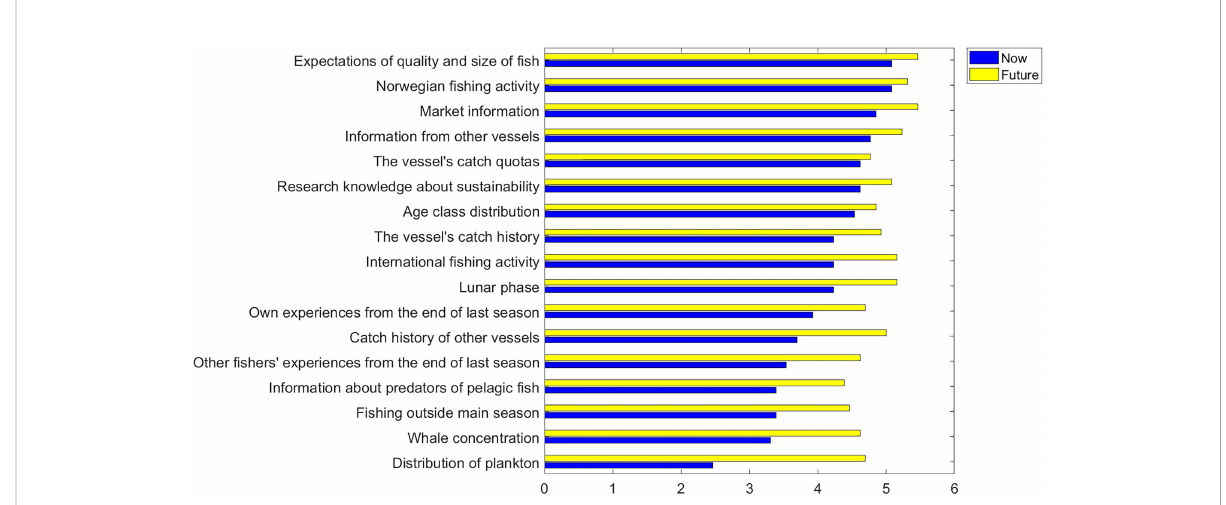
FIGURE 2 Response to Question: How important are the following factors when deciding when and where the new fi shing season should begin? The blue bars indicate how important they are now, while the yellow bars signal the importance of better information in the future. The bars display the mean value (N =